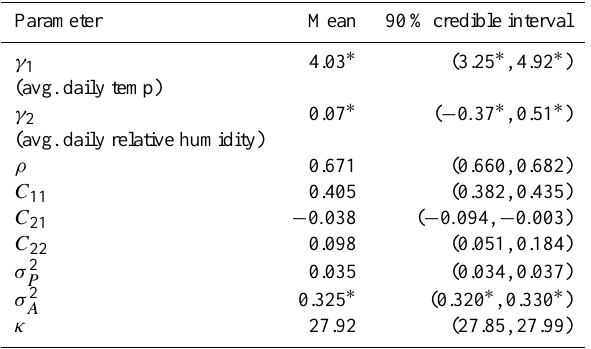
Table 1. The posterior mean and 90% credible interval for param-